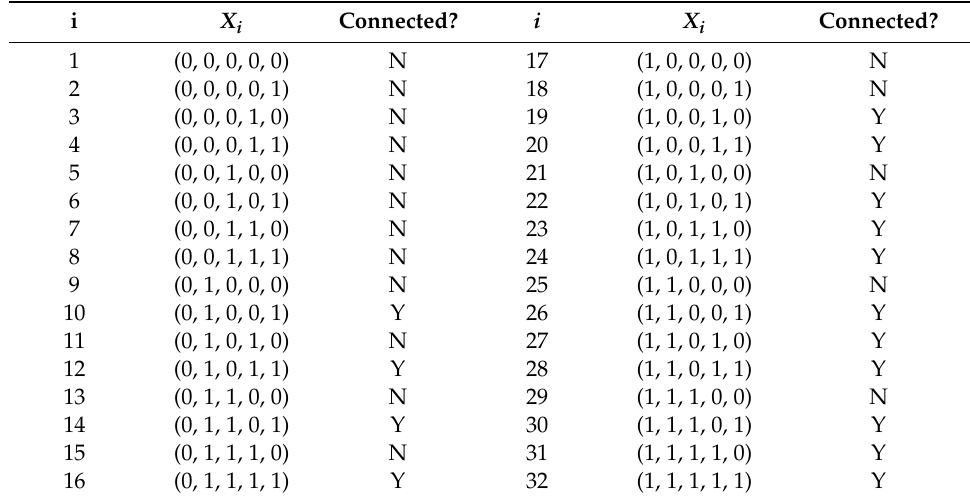
Table 4. All the X i obtained in the BAT.